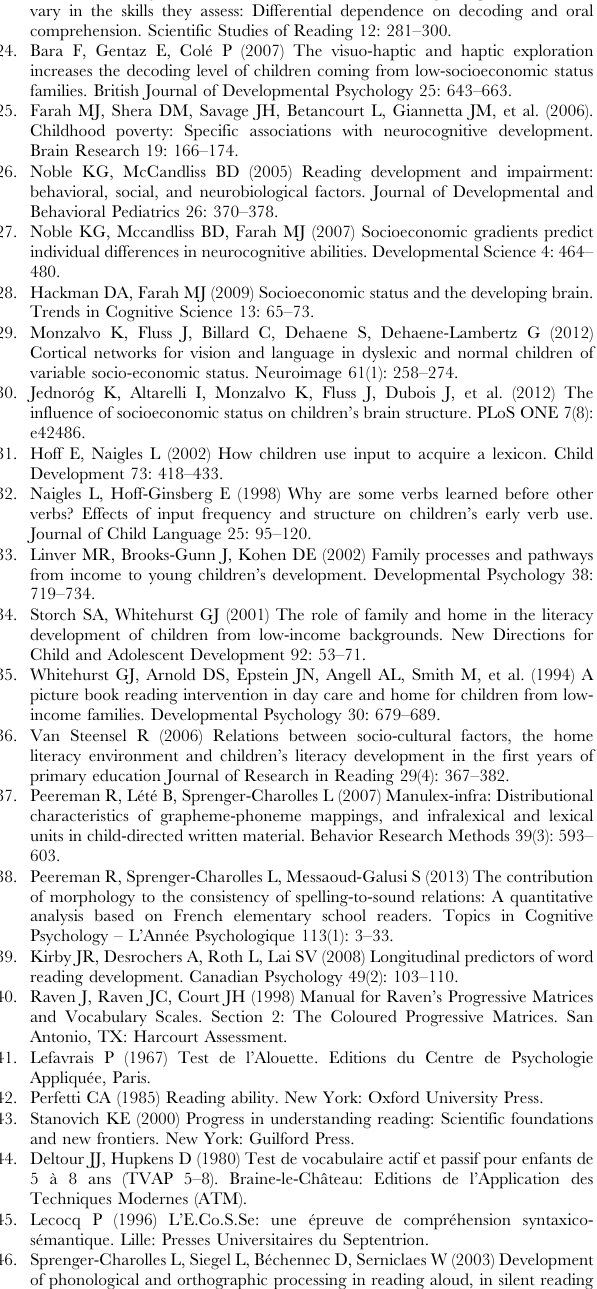
Figure S1 Listening and reading comprehension: Struc- tures tested and examples. The mean % (and ranges) of children providing a correct response for the different utterances are those